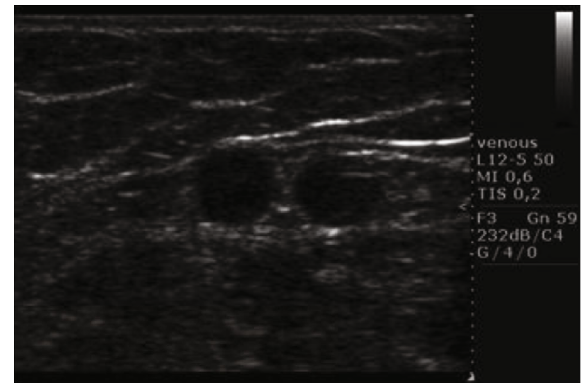
Figure 1: Double great saphenous vein.